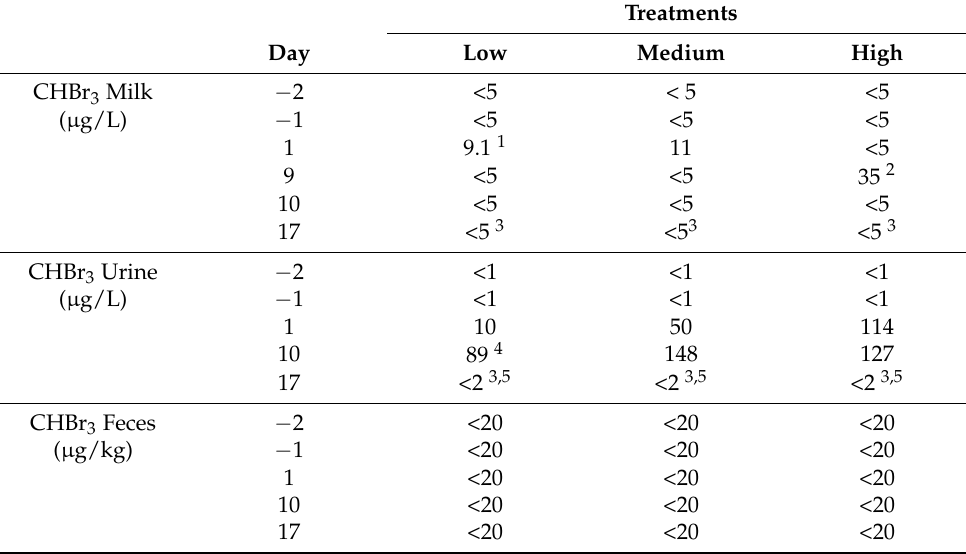
Table 3. Levels of bromoform (CHBr 3 ) in milk, urine, and feces of the dairy cows on different days relative to the first day of offering seaweed mix containing A. taxiformis . Averages are calculated based on values above the detection limit, otherwise, the detection limit is